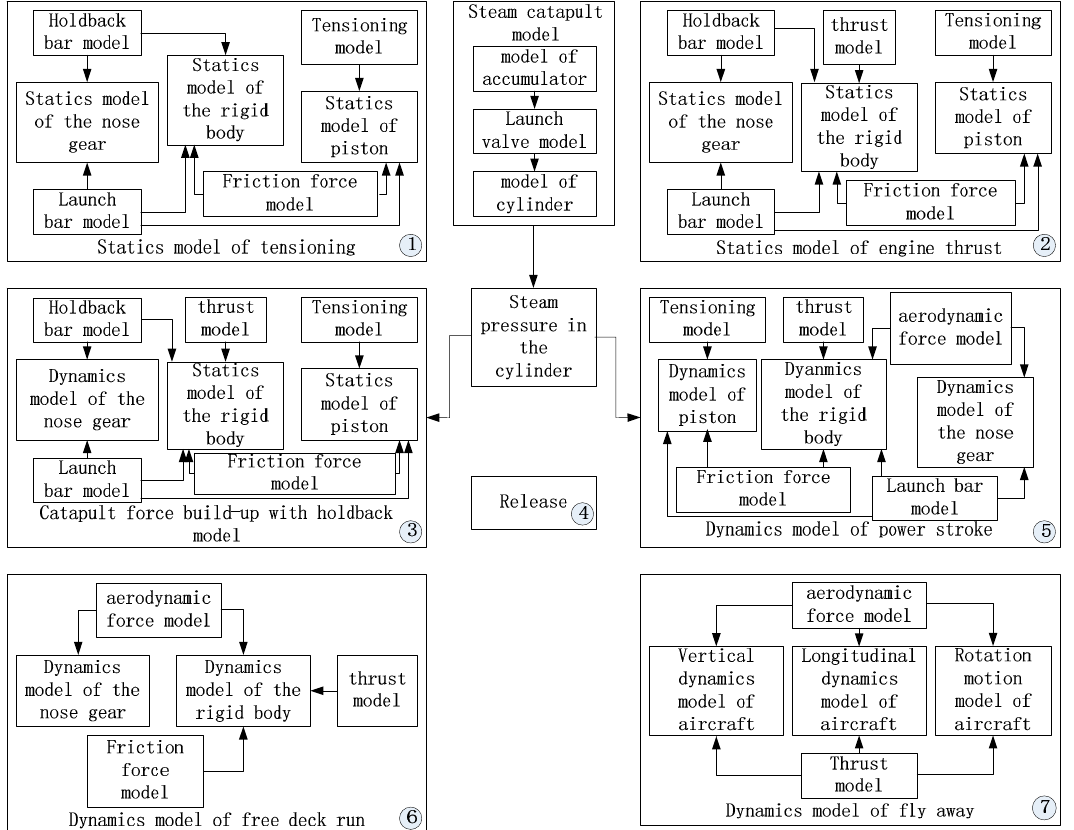
Figure 3. Structure block diagram of steam catapult launch